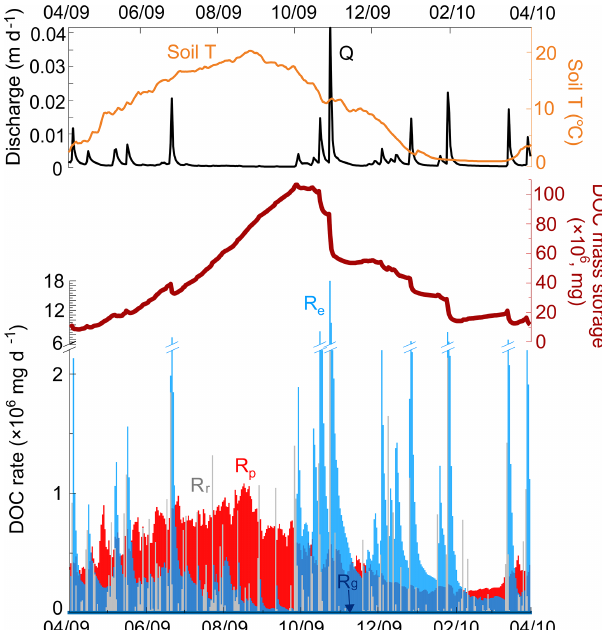
Figure 6. Temporal dynamics of DOC storage, influent rate (rainfall R r , groundwater R g , production R p ), and outflow rate (effluent R e ) at the catchment scale. The stored DOC mass (dark red line) was calculated as follows: (DOC influent rate − outflow rate) × time. The temporal R e dynamics mostly followed the trend of discharge (black line, top panel), whereas R p mostly followed the trend of soil T (orange line, top